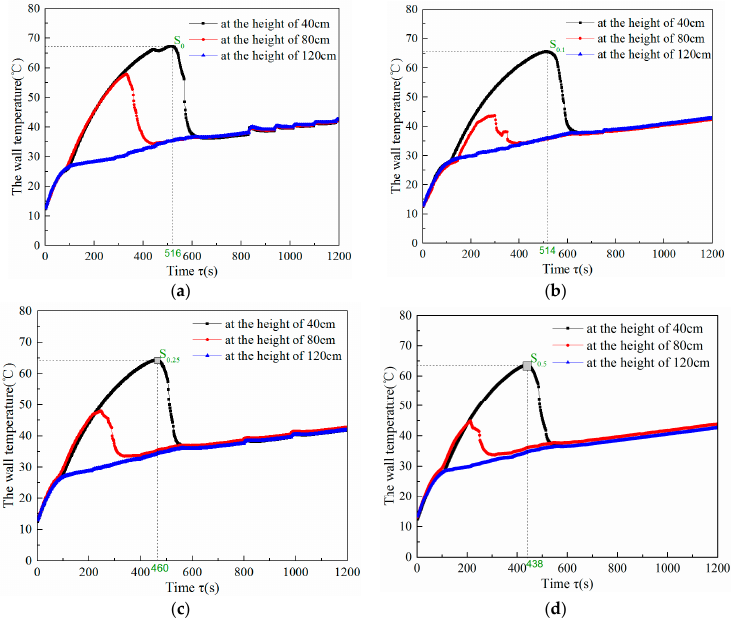
Figure 10. Variations of wall temperatures throughout the duration of the experiment for heat pipes filled with different kinds working fluid under 30 W heating power. ( a ) Deionized water heat pipe; ( b ) Nanofluid enhanced heat pipe with a 0.01 wt % concentration of GNPs; ( c ) Nanofluid enhanced heat pipe with a 0.025 wt % concentration of GNPs; ( d ) Nanofluid enhanced heat pipe with a 0.05 wt % concentration of